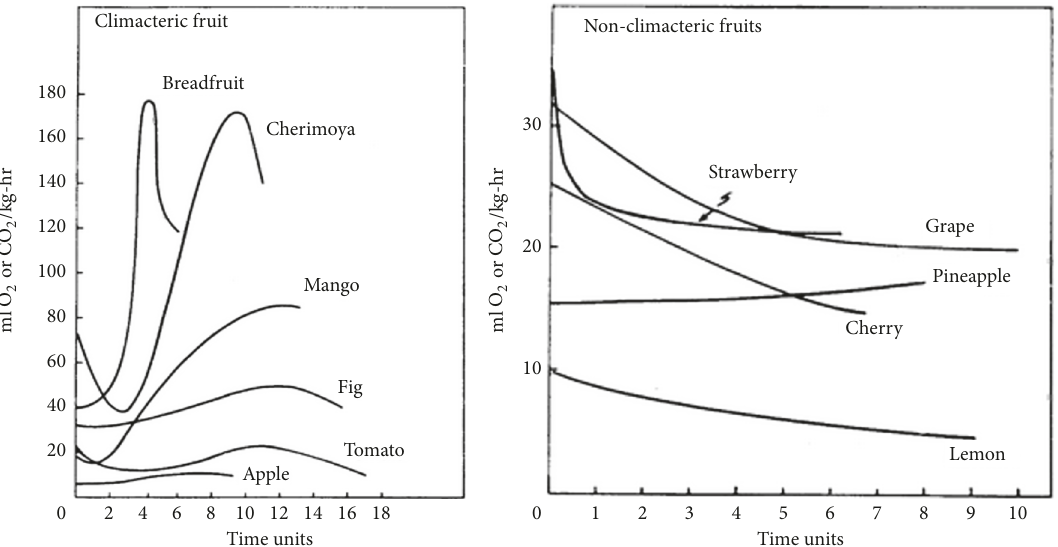
Figure 1: Respiratory pattern during ripening of climacteric and nonclimacteric fruits (source [10]).